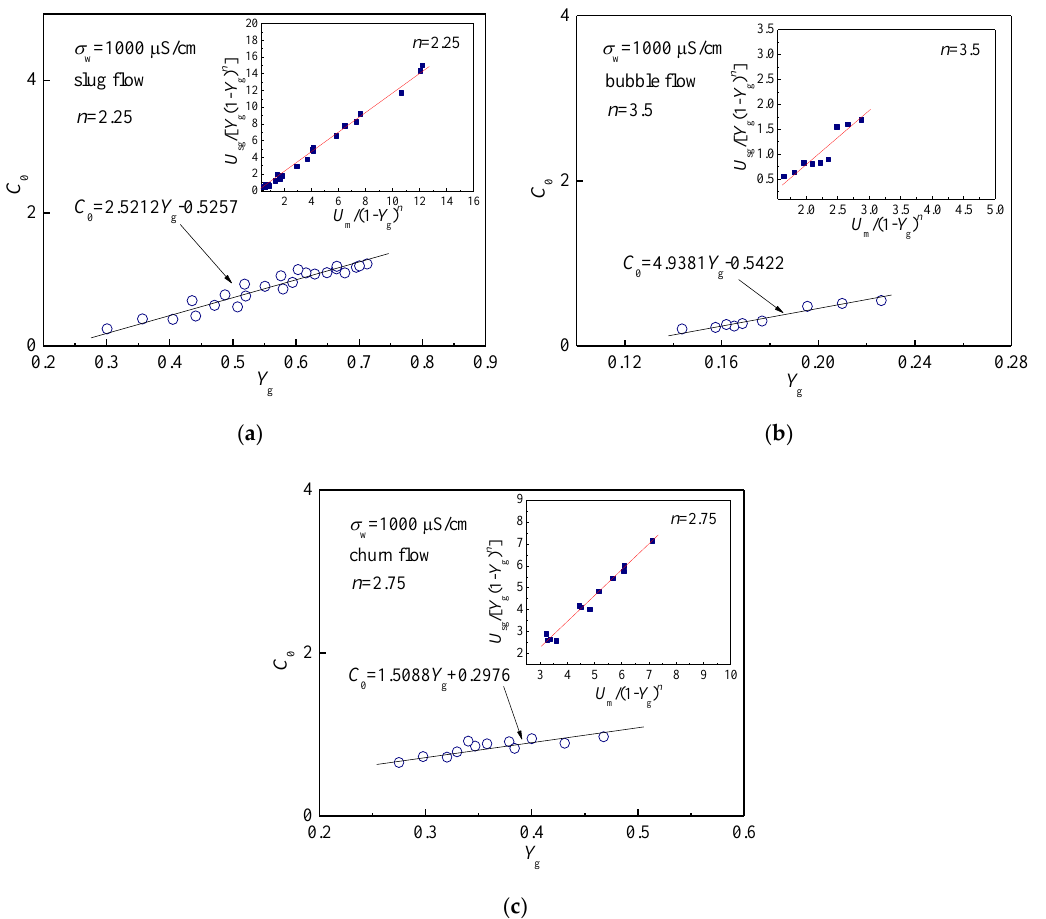
Figure 13. The determination of n and C 0 in three typical flow patterns and water conductivity of 1000 μS/cm : ( a ) Slug flow; ( b ) Bubble flow; ( c ) Churn flow.